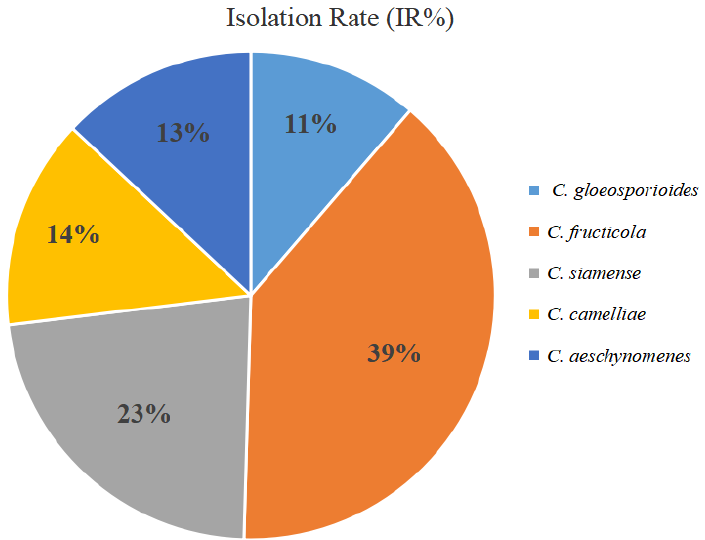
Figure 2. Isolation Rate (IR%) of Colletotrichum species isolated from Ca. japonica leaves. 3.2. Taxonomy